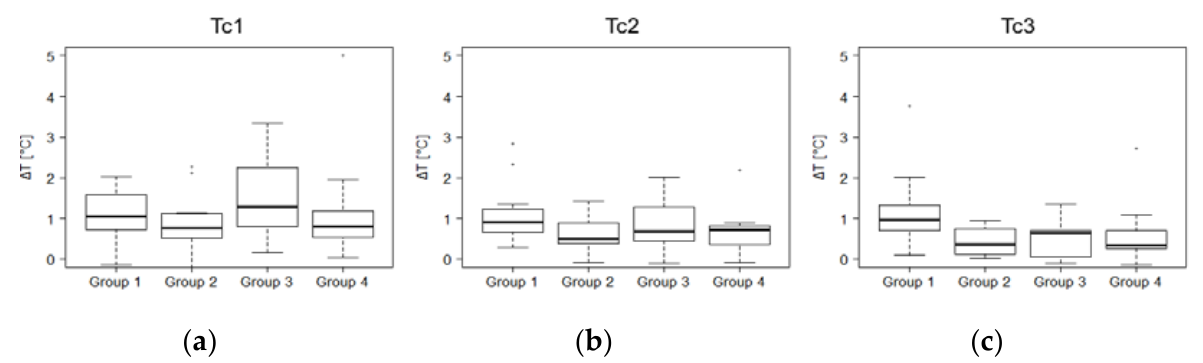
Figure 7 . Boxplots showing the average temperature variation (ΔT) with respect to starting tem- Figure 7. Boxplots showing the average temperature variation ( ∆ T) with respect to starting temperature at ( a ) Tc1, ( b ) Tc2, perature at ( a ) Tc1, ( b ) Tc2, and ( c ) Tc3 in the four groups. and ( c ) Tc3 in the four groups.